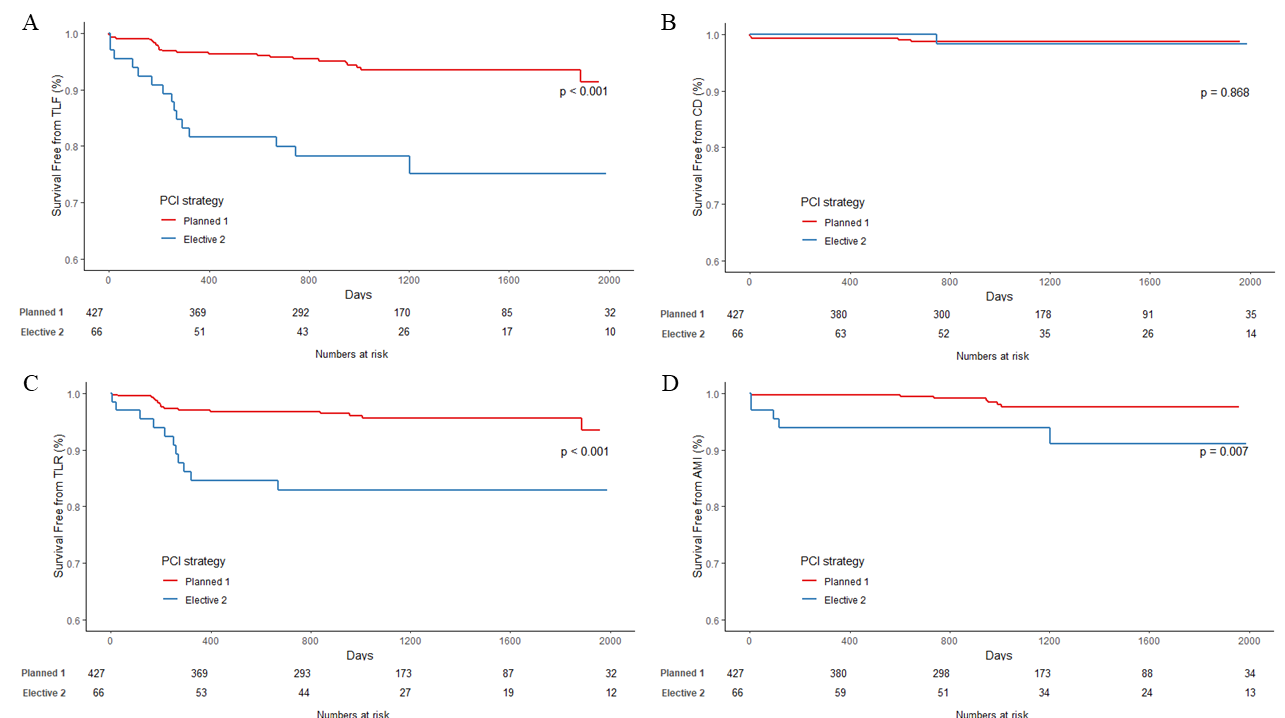
Figure 2. Kaplan–Meier curves in patients with non-LAD bifurcation lesions according to PCI strategies: planned one-stent (red) or elective two-stent (green). Curves are for ( A ) TLF, ( B ) cardiac death, ( C ) AMI, and ( D ) TLR, respectively. AMI = acute myocardial infarction; PCI = percutaneous